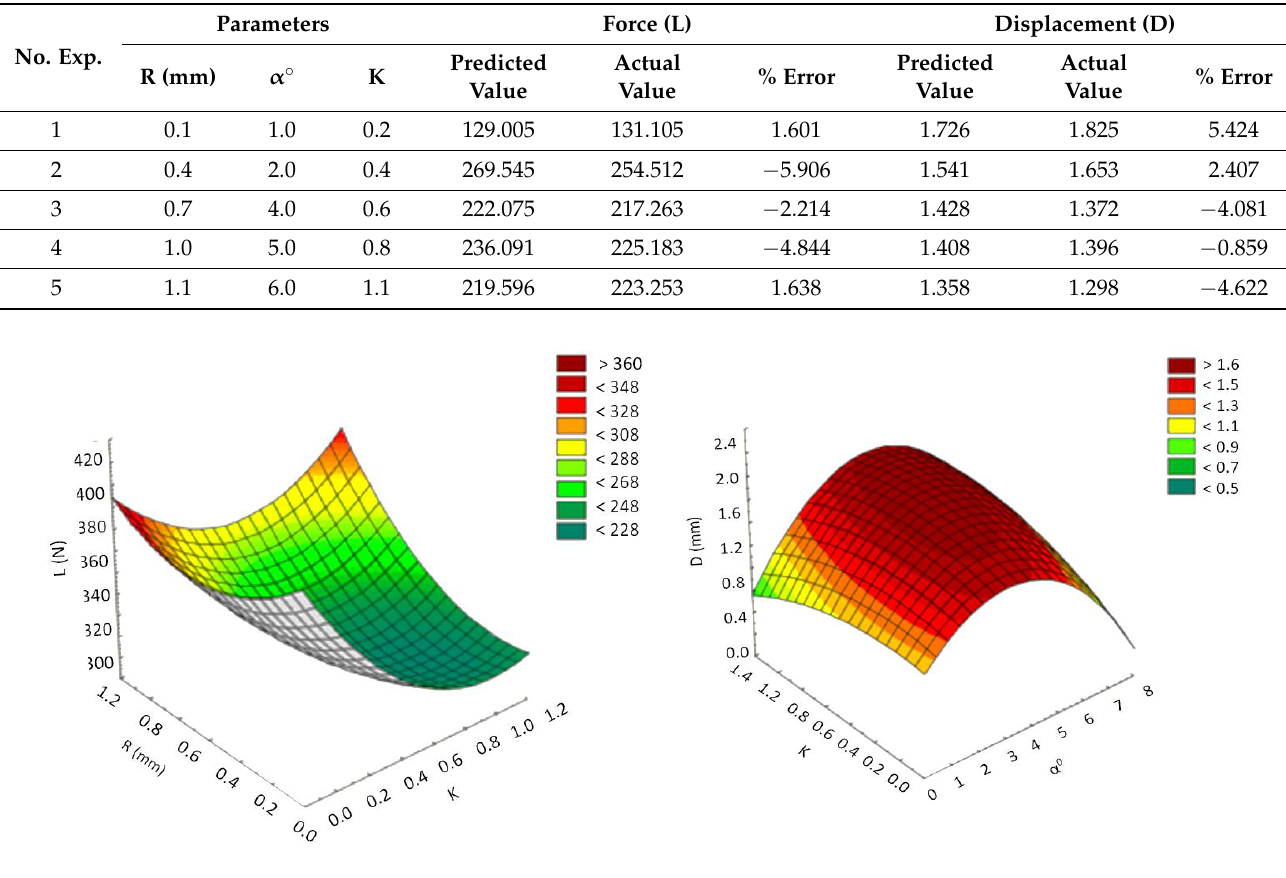
Table 9. Experiments used to confirm the mathematical model for force (L) and displacement (D) for artificially aged parts.